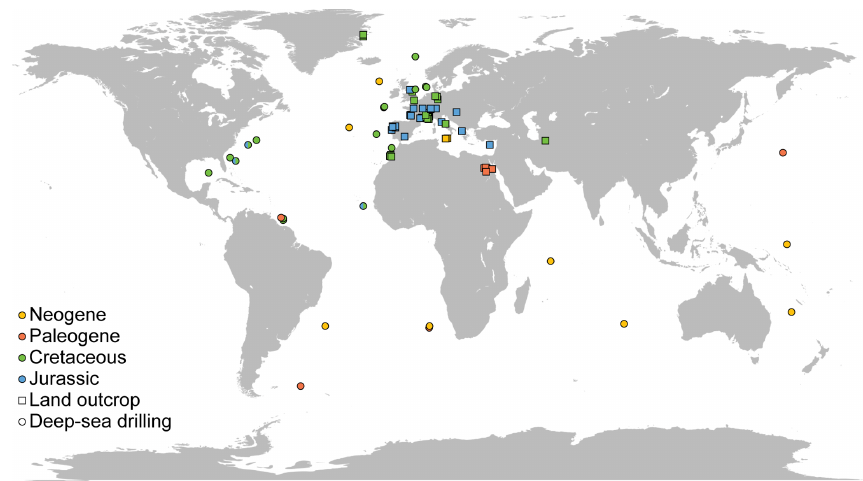
Figure 1. Location of the sites compiled for this study. Colors indicate the age of the samples (Neogene, yellow; Paleogene, orange; Creta- ceous, green; Jurassic, blue). Squares represent land outcrops and circles represent deep-sea